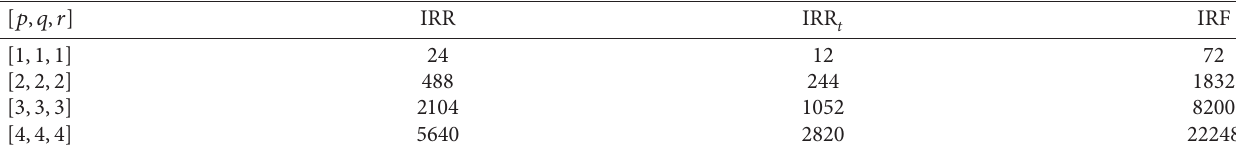
t , and IRF for crystallographic structure of titanium difluoride